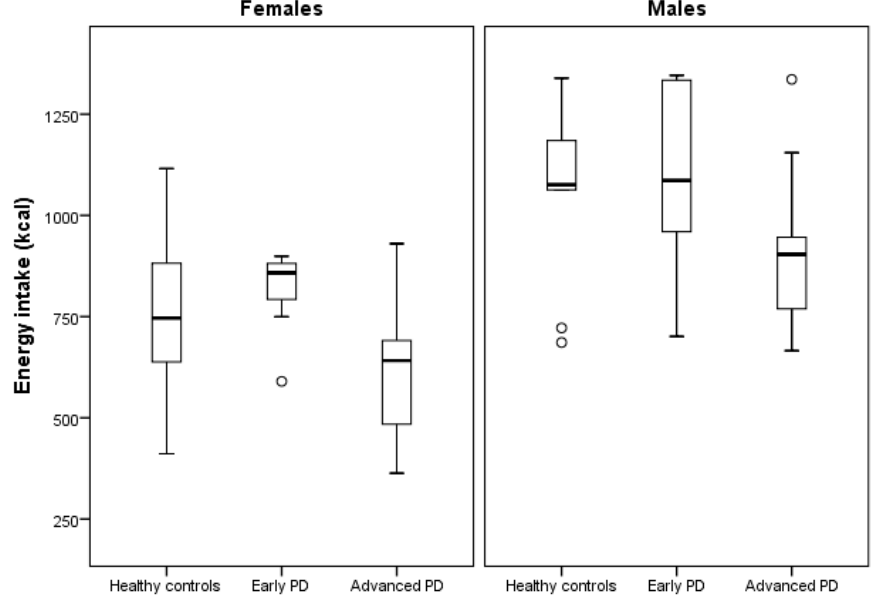
Figure 3. Boxplot illustrating group differences in energy intake (kcal) after sex stratification. Figure3. Boxplotillustratinggroupdi ff erencesinenergyintake(kcal)aftersexstratification. Parkinson’s disease (PD). Each circle represents a participant with an energy intake value > 1.5 × interquartile